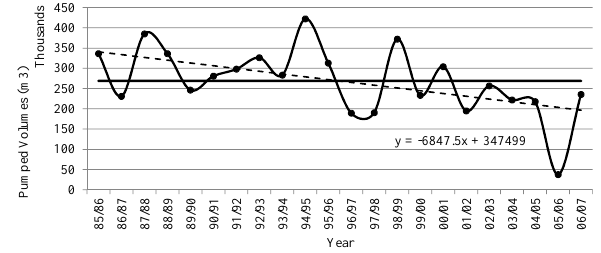
Fig. 11. Annual volumes pumped by the sand bypass scheme. The solid horizontal line shows the average annual volume while the dashed line shows a fitted linear trend.